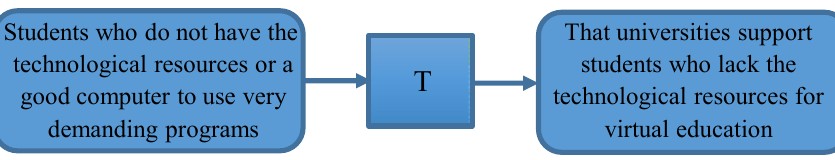
Fig. 4. Support for students who do not have sufficient